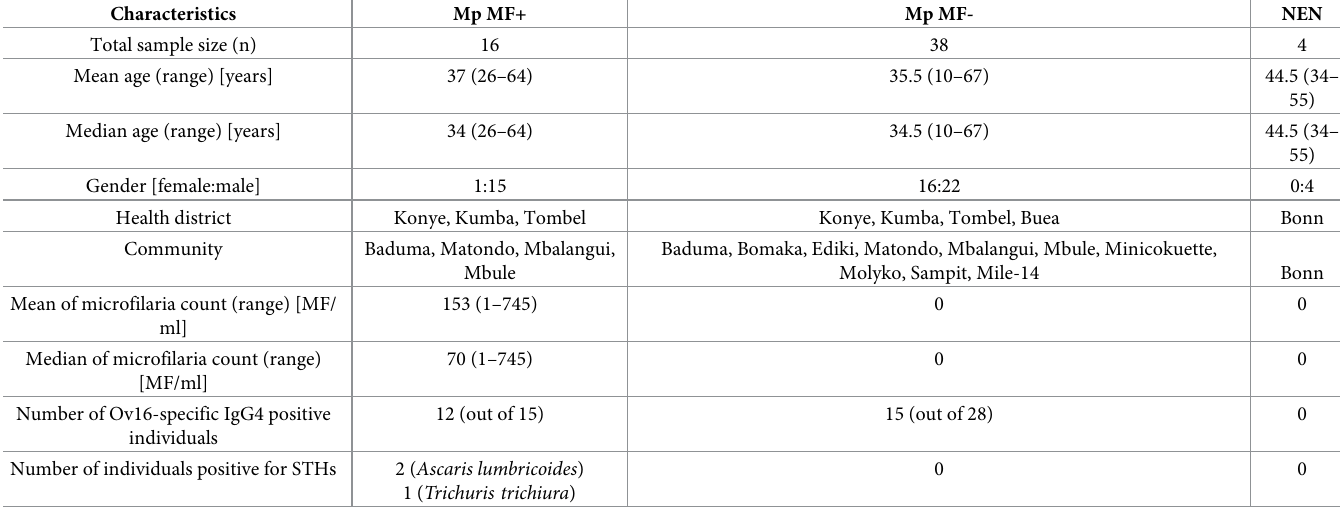
Table 1. Characteristics of the overall study population. According to their diagnostic status, individuals were categorized as either M . perstans- microfilaremic (Mp MF +) or amicrofilaremic (Mp MF-). Microfilariae (MF) numbers are given as mean and median with range. Four healthy European donors (non-endemic normals, NEN) were also recruited into the study. The table shows total sample size, age, gender, health districts and communities of the participants and numbers of individuals which are positive for Ov16-specific antibodies and soil-transmitted helminths (STHs).